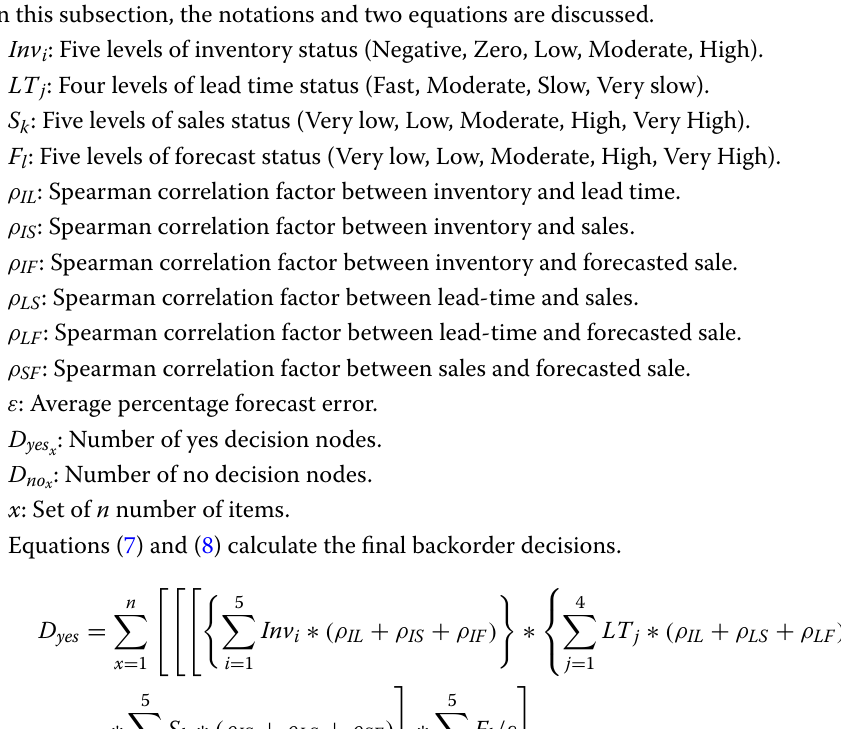
Prediction equations and notations In this subsection, the notations and two equations are